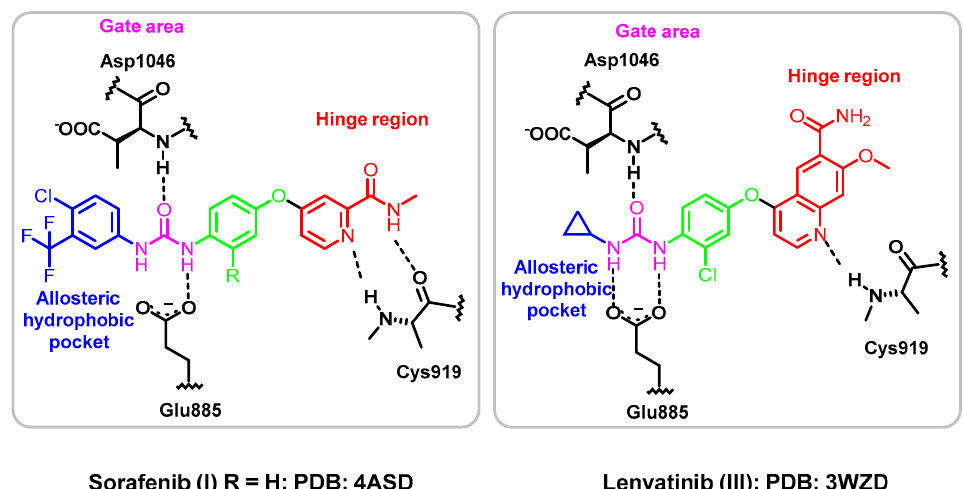
Figure 2. Representation of type II VEGFR-2 inhibitors I – III in the VEGFR-2 active site.